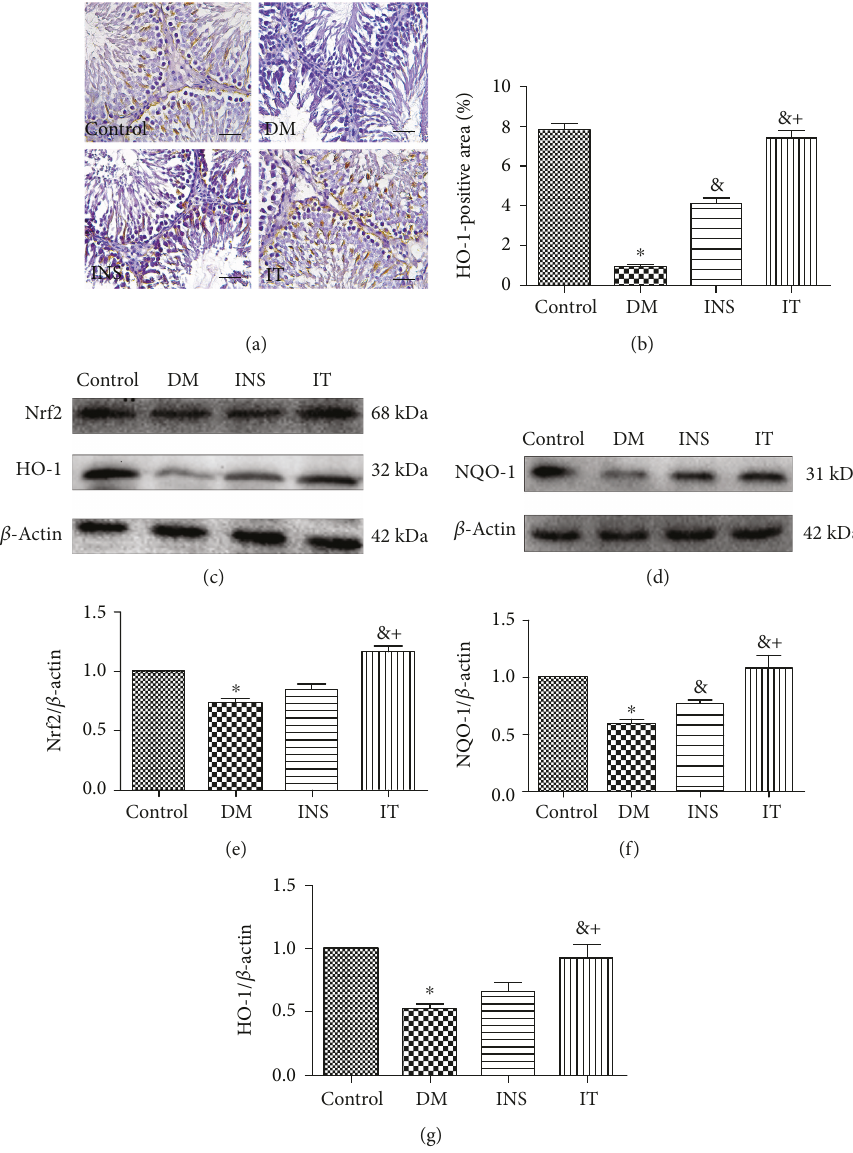
Figure 4: Islet transplantation treatment activated the Nrf-2/HO-1 pathway in the testicular tissues of diabetes-induced rats. (a, b) Immunohistochemical staining ( × 400) ( bar = 25 μ m ) and quantitative analysis of positive regions showing the expressions and typical distribution of HO-1 in testicular sections. Compared with those of the INS and DM groups, the expression level of HO-1 signi fi cantly increased after IT ( n = 6 for each group). (c – g) Representative Western blot images of Nrf2, HO-1, and NQO1 and quanti fi cations of their expression levels in testicular tissues. DM induced a marked decrease in these parameters. Treatment by IT signi fi cantly increased the expression of Nrf2, HO-1, and NQO1. The expressions of these proteins in the INS group were only slightly altered ( n = 6 for each group). DM: diabetes mellitus; INS: insulin treatment; IT: islet transplantation. ∗ P < 0 05 vs. control; & P < 0 05 vs. DM; + P < 0 05 vs.